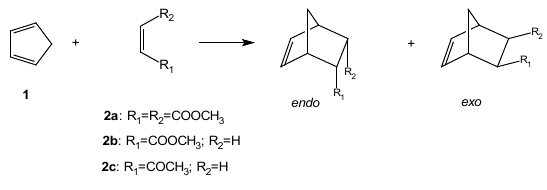
Scheme 1. The reaction of cyclopentadiene (1) with selected dienophiles - dimethyl maleate (2a), methyl acrylate (2b), methyl-vinyl ketone